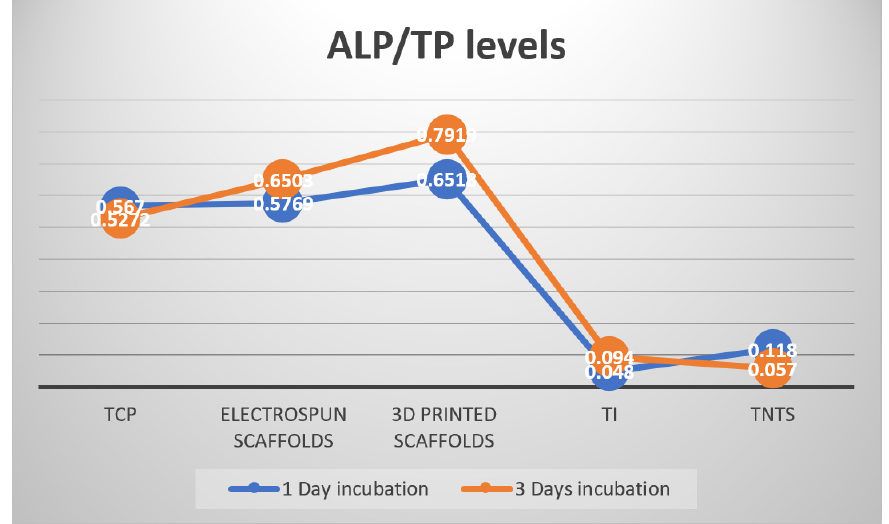
Figure 12. ALP/TP levels measured in osteoblasts and 1 and 3 days of incubation while seeded on the following substrates: TCP (Tissue Culture Polystyrene), Electrospun Scaffolds, 3D printed Scaffolds, Titanium (Ti) andTitania Nanotubes (TNTs).